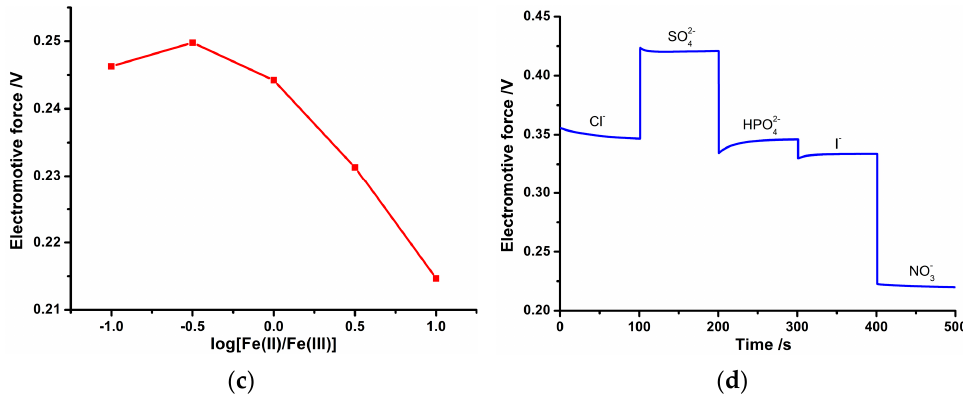
Figure 14. EMF dependence on the logarithm of the activity of PPy -NS ISE ( a ) and PPy-Au-NS ISE ( b ) days later. Redox sensitivity ( c ) and ion selectivity ( d ) of the PPy-Au-NS ISE. PPy (NO 3 − )-ISM was synthesized for polymerization duration 1800 s, while PPy-Au-NS ISE was synthesized at Au 3+ concentration 2.5 mM of the electrolyte.